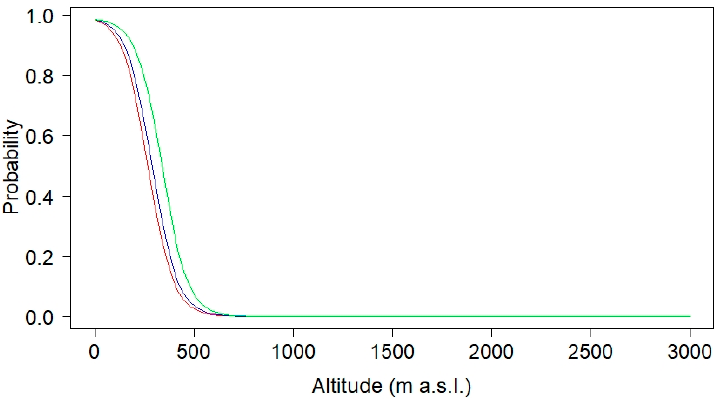
Figure 1. The probability of damage to box trees by Cydalima perspectalis predicted by altitude. Red line—high damage; blue line—high or medium damage; and green line—any damage (high, medium, or low damage).